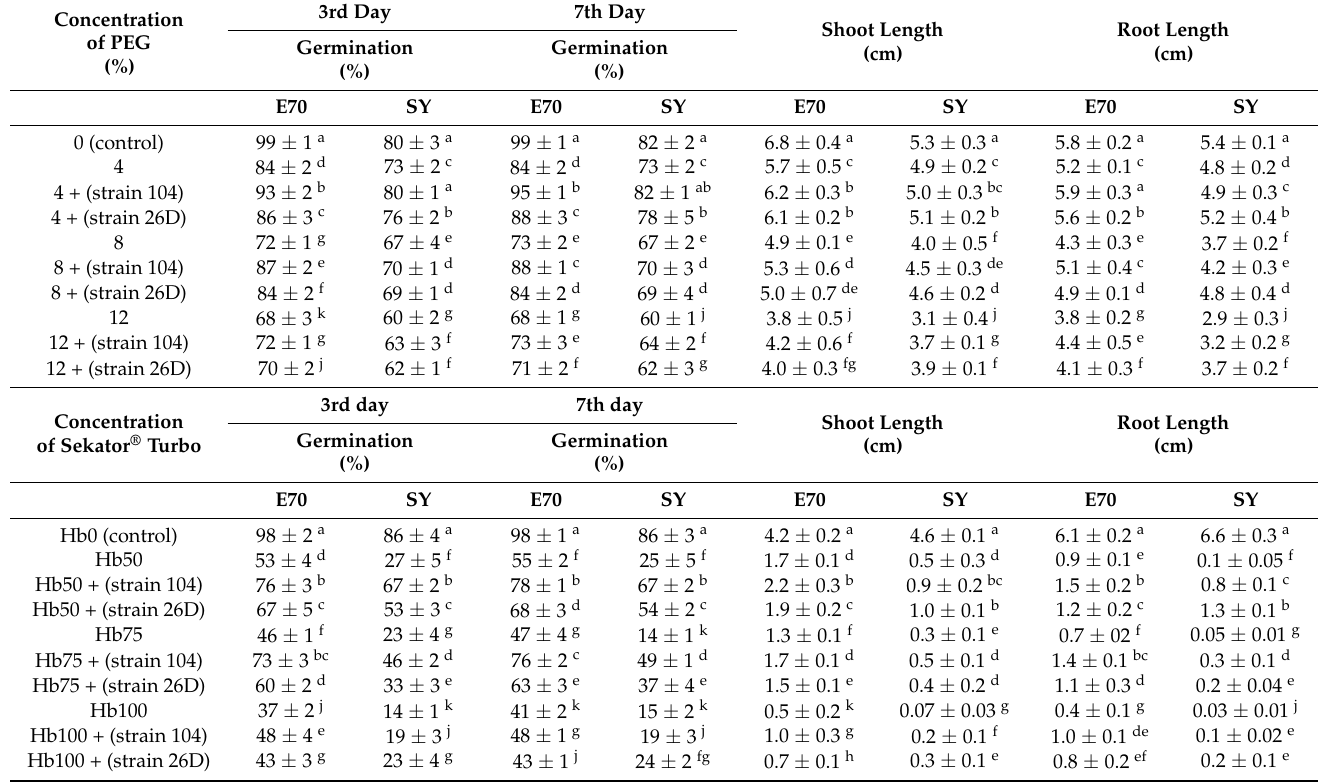
Table 1. Effect of various concentrations of Sekator ® Turbo-induced herbicide stress and PEG-induced drought stress on seed germination and early seedling growth in wheat ( Triticum aestivum L.) pre- treated before sowing with Bacillus subtilis (strains 104 and 26D). In the table, standard errors ( ± SE) of the means in triplicate (15 seeds/seedlings per replicate) are represented. Various letters show a significant difference between the averages of different groups at p <